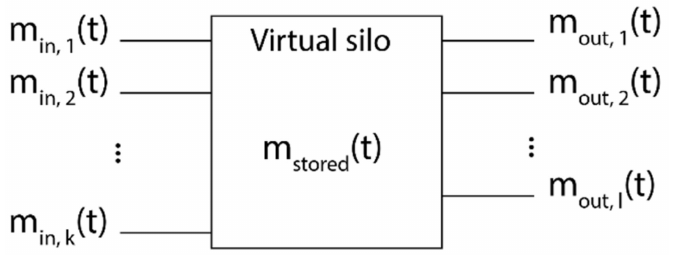
Figure 3. General form of a virtual silo with k inflows and l outflows. Redrawn after [13]. If only one type of material is transported, the in- and outflows can be simplified to a sum of the inflows and the sum of the outflows. Equation (1) presents the sum of all the inflows at time t